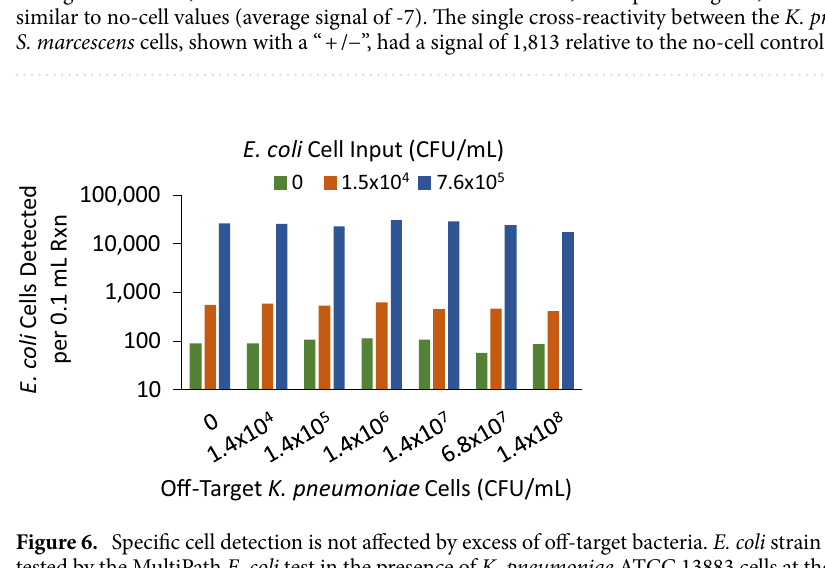
Figure 6. Specific cell detection is not affected by excess of off-target bacteria. E. coli strain ATCC 25922 was tested by the MultiPath E. coli test in the presence of K. pneumoniae ATCC 13883 cells at the concentrations shown. Matrix was SEC-processed urine and the test carried out in microwell plates with lyophilized reagents. Bars represent the average of duplicate reactions. Detected cells for 7.6 × 10 5 input E. coli was estimated from total